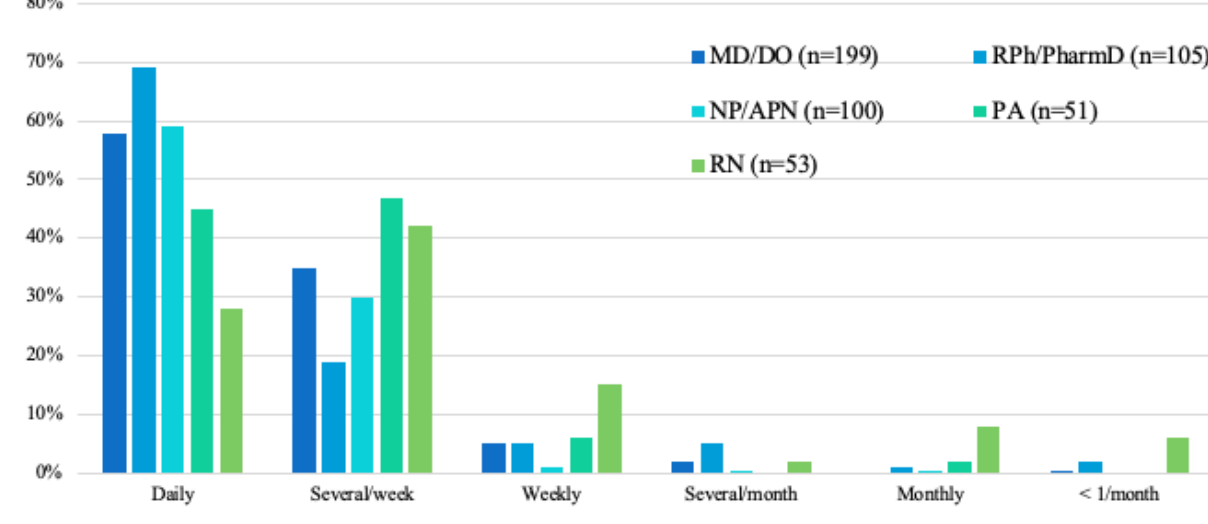
Figure 1. Frequency of medical information searches. APN: advanced practice nurse; DO: Doctor of Osteopathic Medicine; MD: medical doctor; NP: nurse practitioner; PA: physician assistant; PharmD: Doctor of Pharmacy; RN: registered nurse; RPh: registered pharmacist.